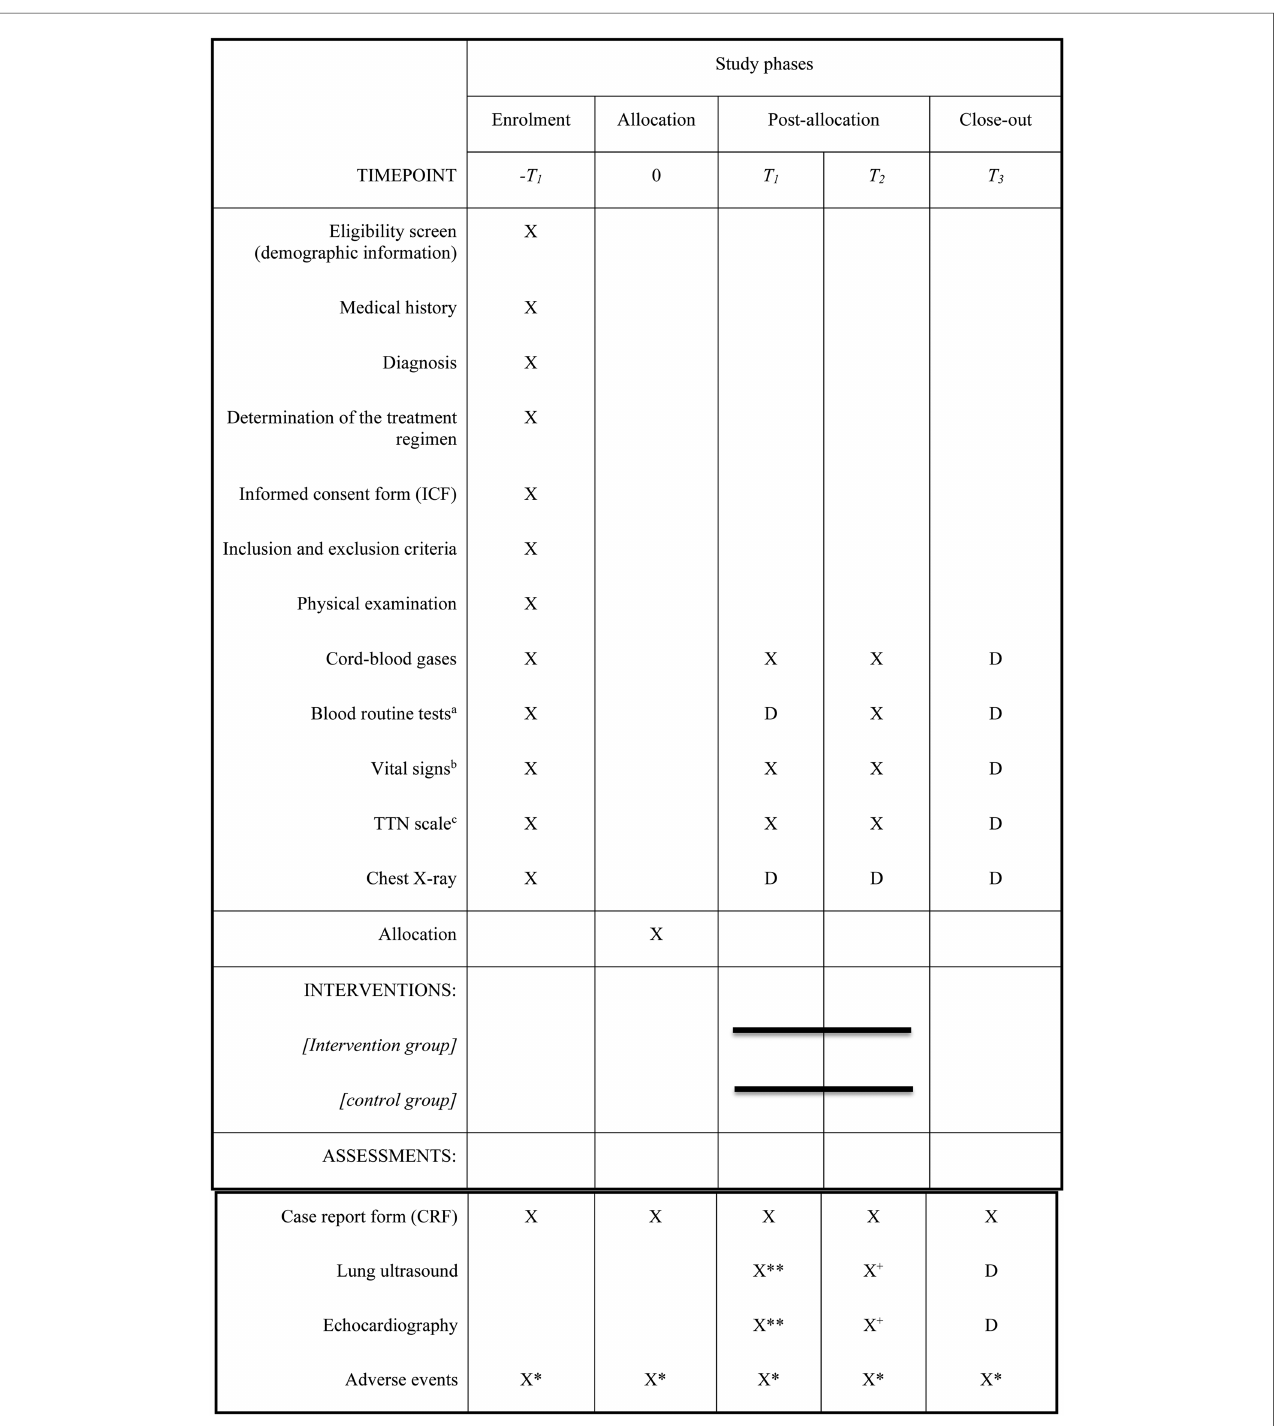
FIGURE 2 The schedule of enrolment, interventions, and assessments in the REFSAL study. D – possible performance of an additional examination according to the decision of the attending physician. Obligatory in the case of intubation, pneumothorax, or sudden deterioration of the patient ’ s condition – procedures should be performed within 6 – 10 h of the patient's deterioration. a Blood count, Ionogram made of venous blood, Blood gases. b Every 1 h within 6 hours of randomization, every 2 h between 6 and 24 h, and every 6 h between 24 and 48 h after randomization and 1 and 4 h after the end of each dose/placebo and at the time when intubation is necessary. c Every 1 h within 6 h of randomization, every 2 hours between 6 and 24 h, every 6 h between 24 and 48 h after randomization, and 1 and 4 h after the end of each dose/placebo and at the time of necessity for intubation. * Adverse events monitored from enrolment until the end of the extended follow-up period, that is, up to seven days of age or hospital discharge. **up to 6 hours after allocation. + 6 – 10 hours after the last dose of